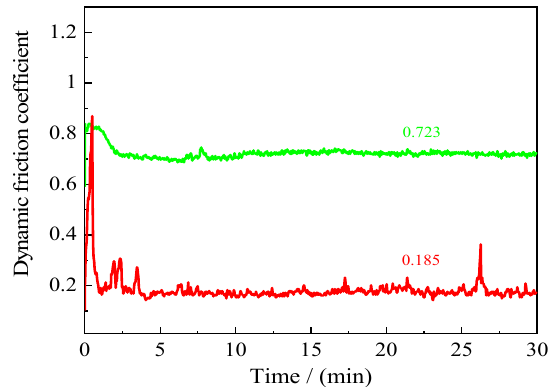
Figure 21. Frictional coefficient of samples before and after laser processing.